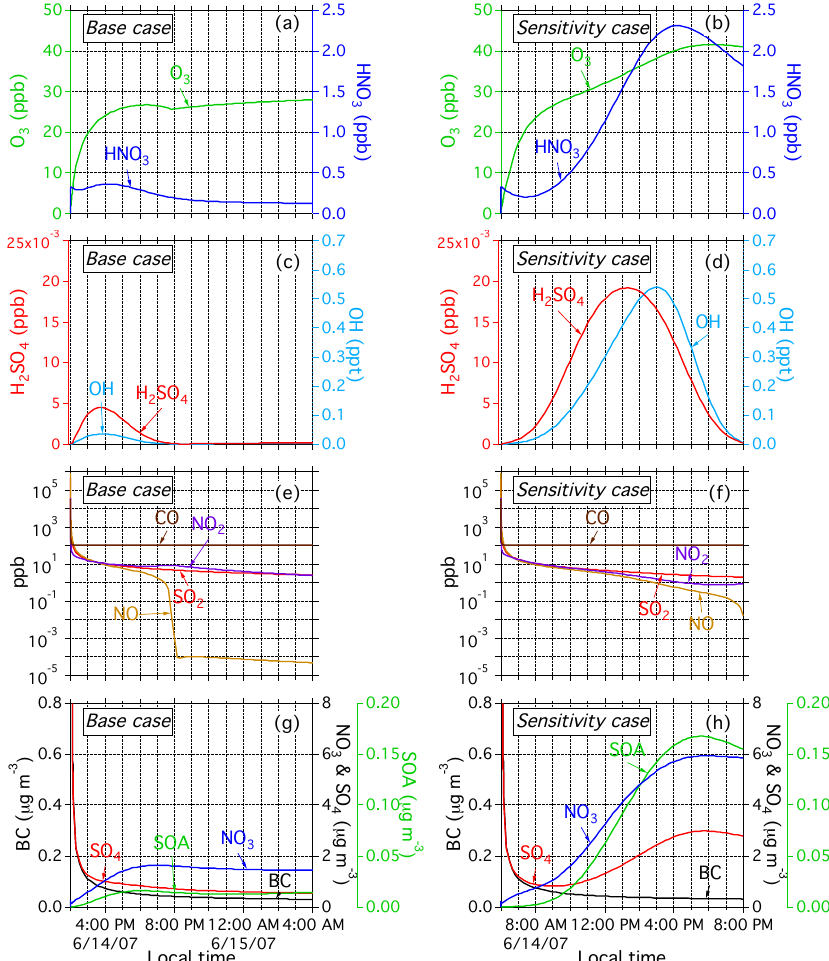
Figure 2. Evolution of gas and bulk aerosol species in the ship plume over a period of 14h for the base case starting from 14:00LT (left column panels) and sensitivity case starting from 06:00LT (right column